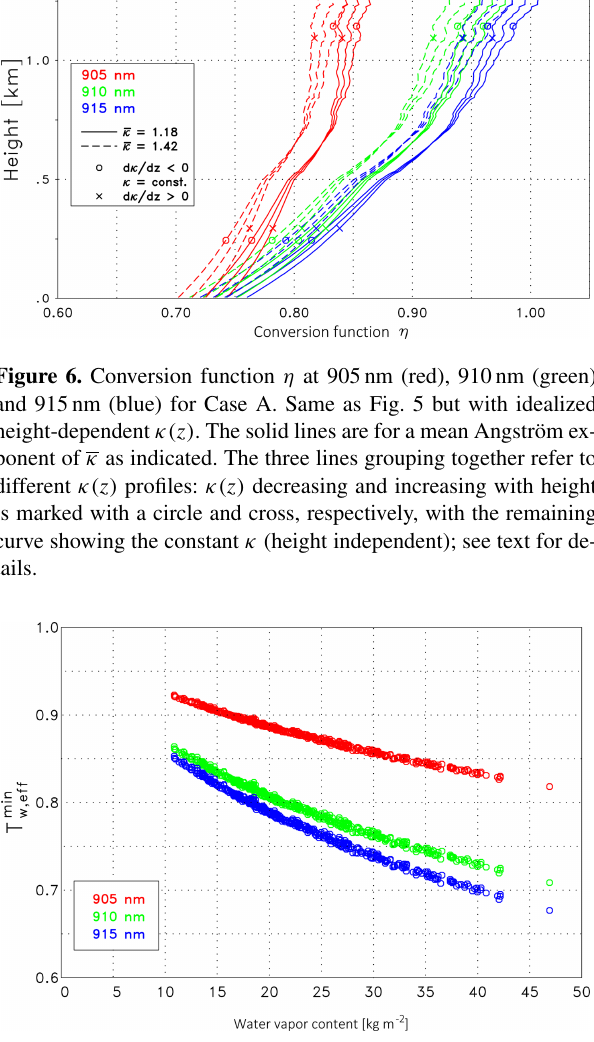
Figure 7. Relation between the total water vapor content w and the water vapor transmission at 10km, T min , determined from all w , eff radiosonde ascents between 27 June and 15 September 2015. The central wavelength of the laser spectrum is indicated in the legend.